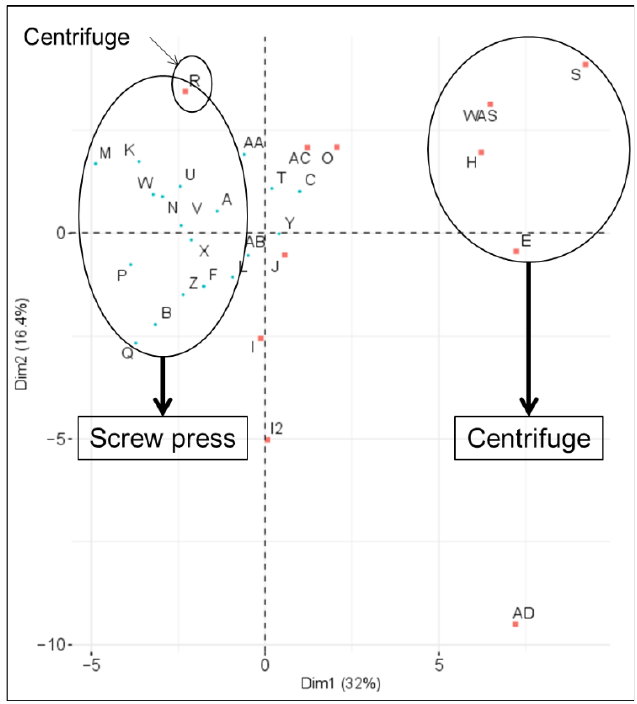
Figure 1. PCA Individuals: Impact of solid – liquid separation.